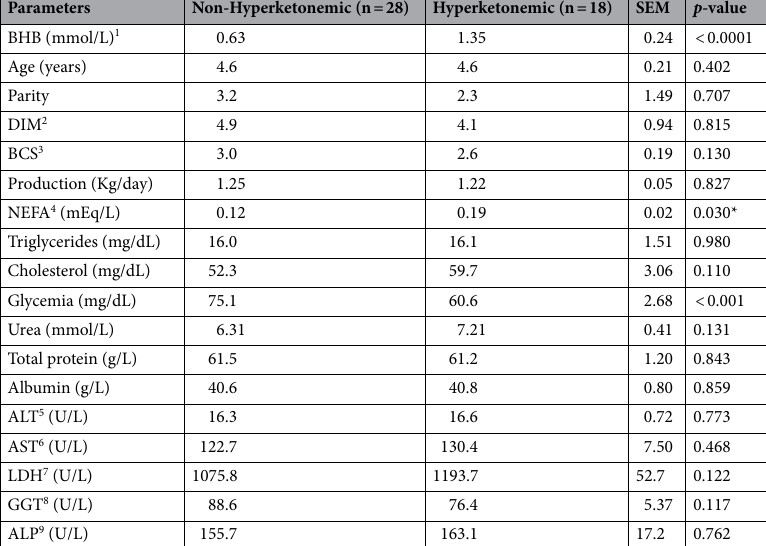
Table 2. Characterization of ewes categorized as non-hyperketonemic group with low BHB or hyperketonemic group with high BHB (BHB > 0.86 mmol/L). 1 β-Hydroxybutyrate. 2 Days in milk. 3 Body condition score. 4 Non-esterified fatty acids. 5 Alanine amino-transferase. 6 Aspartate amino-transferase. 7 Lactate dehydrogenase. 8 γ-Glutamyl-transferase. 9 Alkaline phosphatase; *Significant interaction of the parity class ( p -value = 0.026).